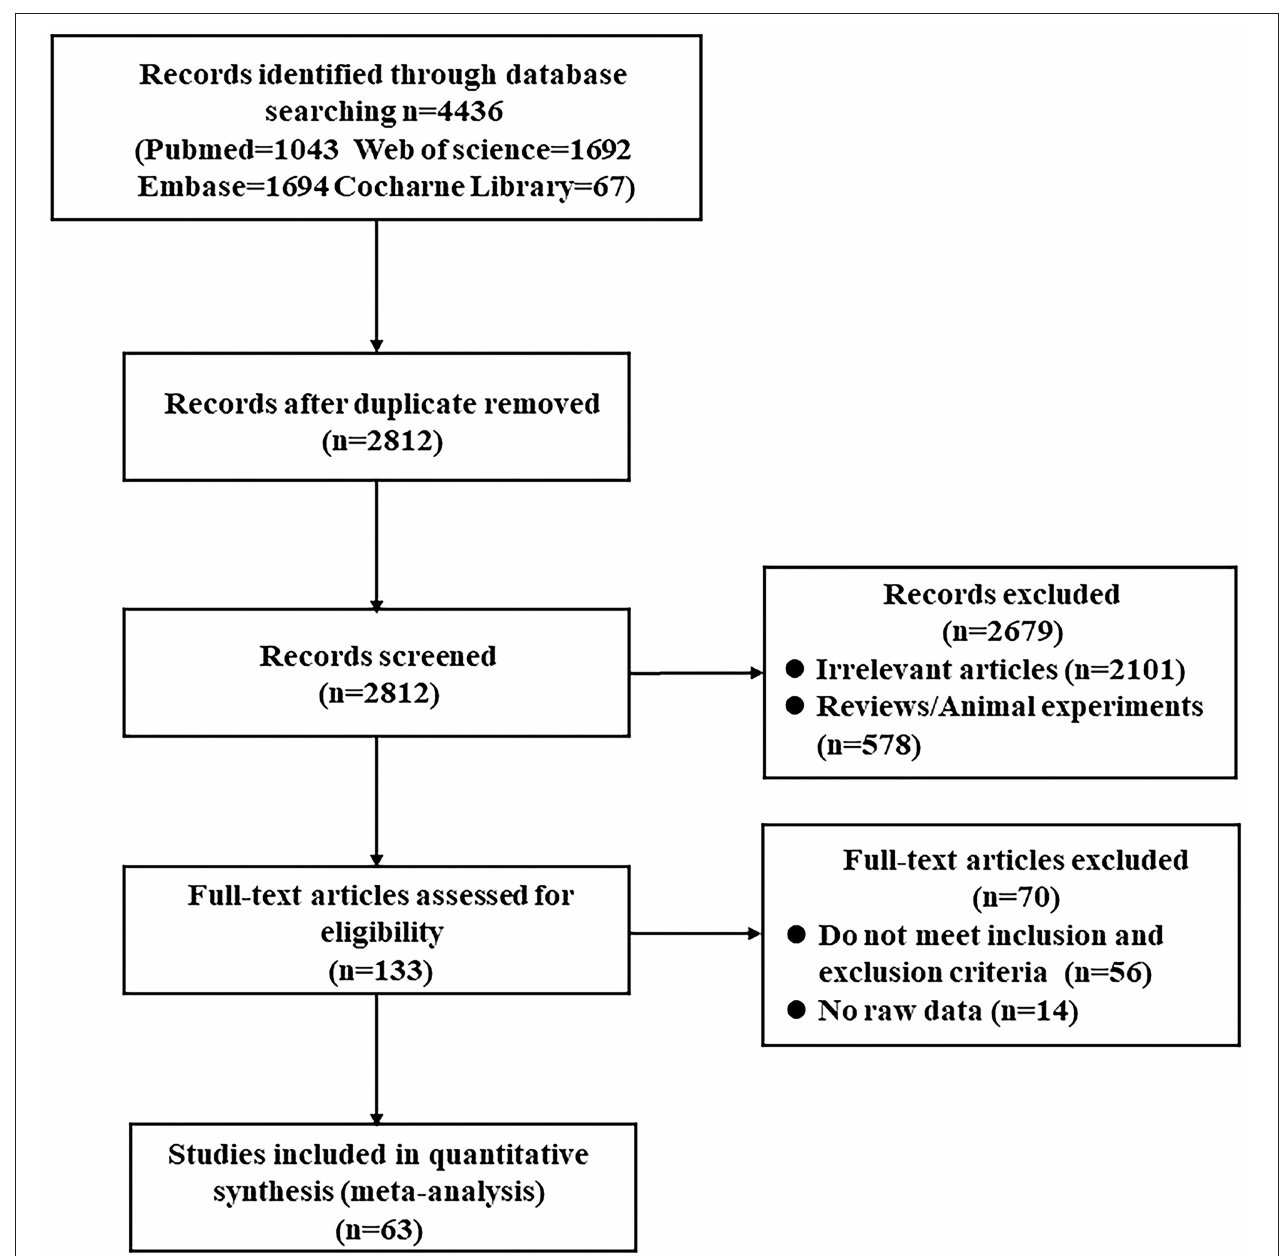
FIGURE 1 | Flowchart for study screening